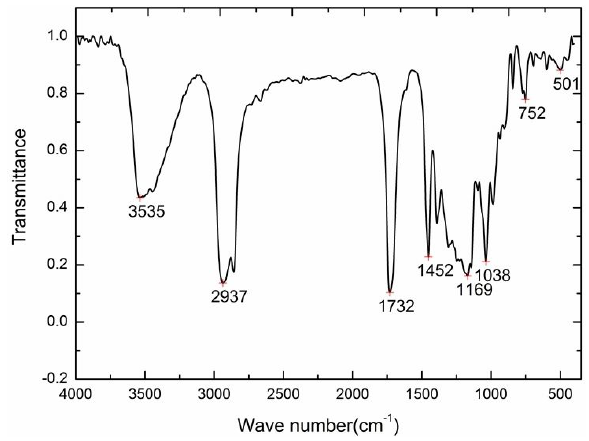
Figure 1: FTIR spectra of polyester